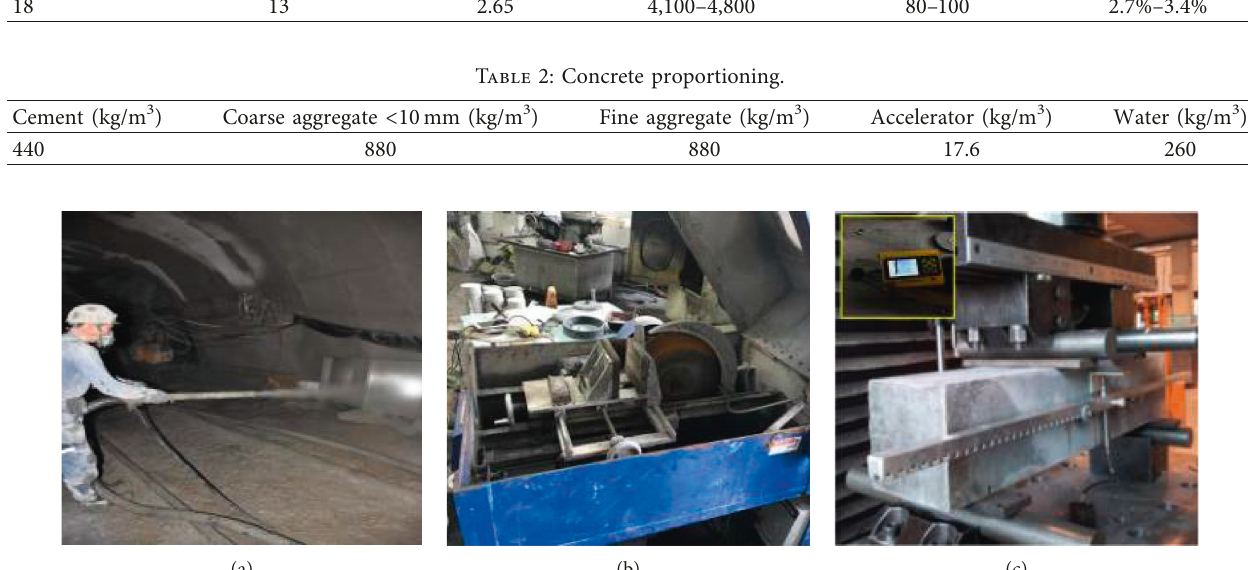
Figure 1: Beam specimen preparation: (a) underground concrete shot and curing, (b) slab cutting, and (c) beam specimen with a crack detector.